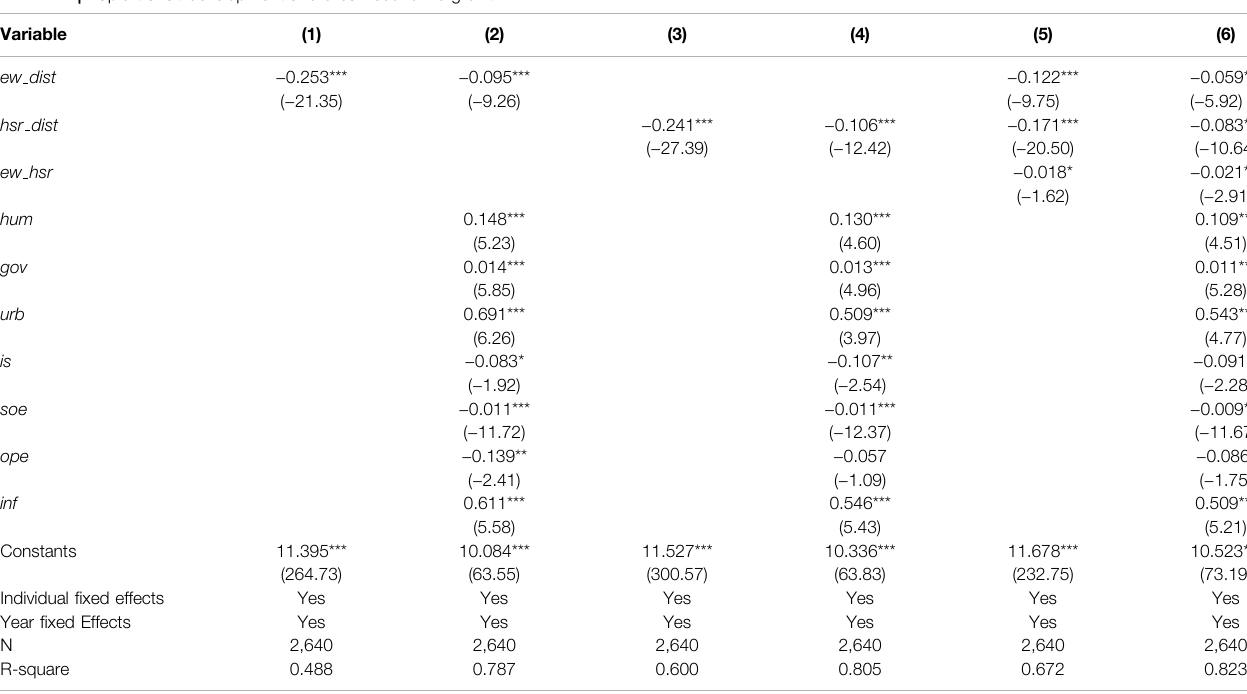
TABLE 2 | Rapid transit development and urban economic growth.